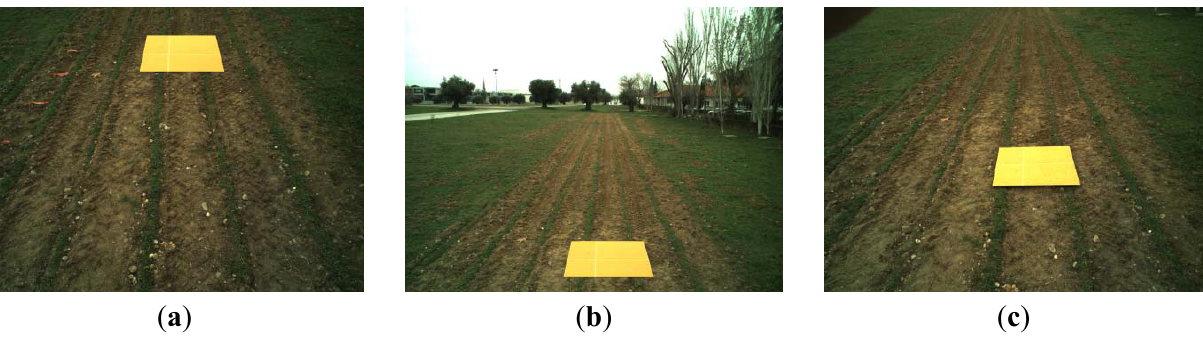
Figure 8. Different images of the ROI (bright orange cardboard) captured with h = 215 cm